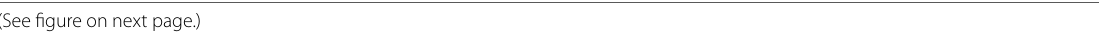
Figure 9 Histological analysis for necrosis assessment: the necrotic depth was assessed by measuring the normal distance from the trench profile to the dashed black line, which marks the interface between the zone with empty lacunae (i.e., necrotic zone) and the zone with filled lacunae (i.e., necrosis‑free zone): ( a ) Control sample free of necrosis, as all lacunae are filled with osteocytes, ( b ) Picosecond laser machining at 5 mm/s (PF) exhibits a necrotic depth of